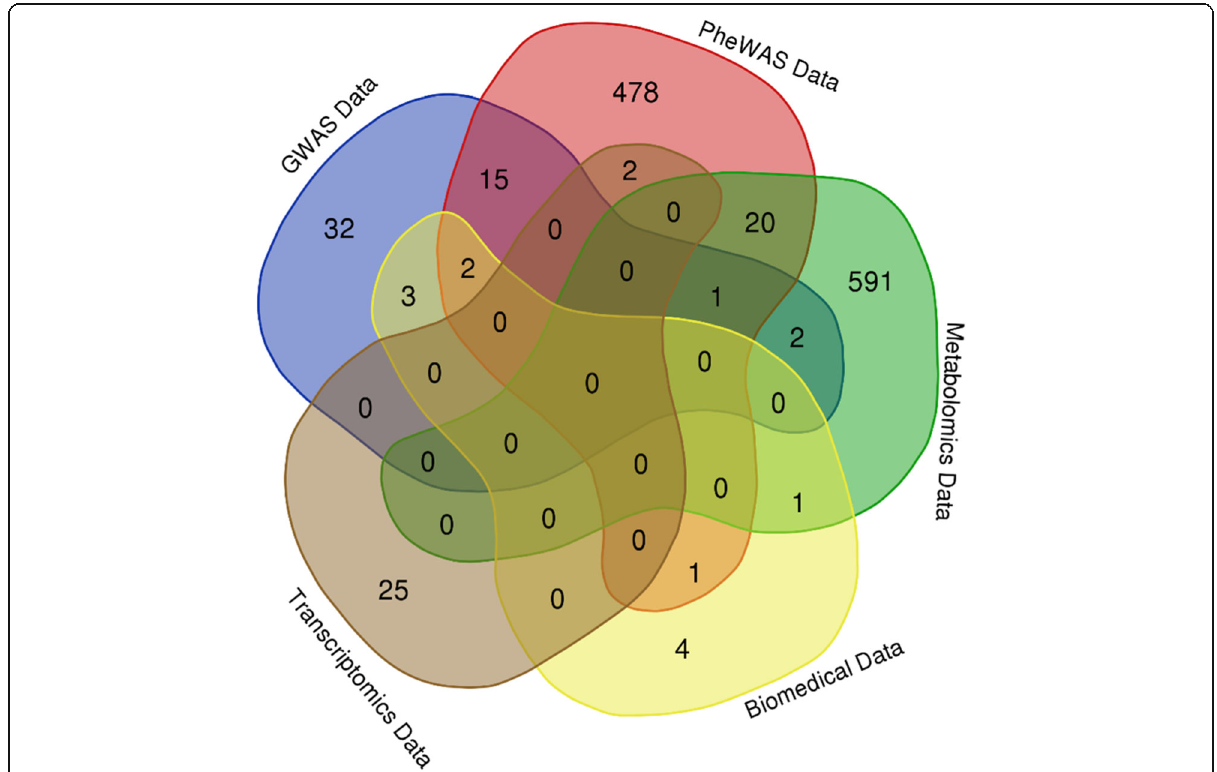
Fig. 2 Venn diagram showing the logical distribution of melanoma associated genes and proteins from revealed from various approaches. Here we have five different datasets for melanoma responsive genes or proteins. There are 50 melanoma associated genes or proteins discovered from more than one approach showing high accuracy in disease related target